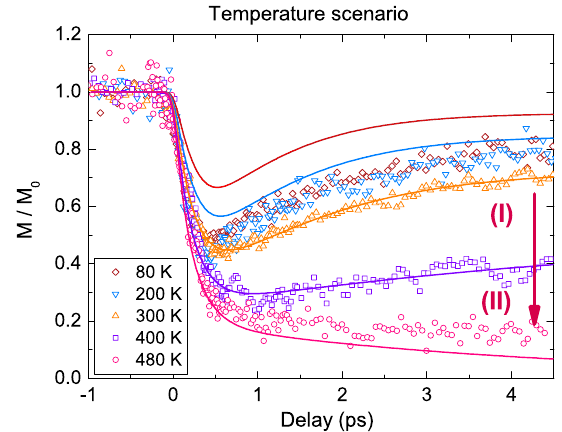
FIG. 3. Dependence of the ultrafast demagnetization of nickel on the ambient temperature T ambient at a fluence of P 0 ¼ 3 : 5 mJ = cm 2 . Demagnetization dynamics measured for five dif- ferent ambient temperatures from 80–480 K (symbols). Lines are calculations with the refined M3TM, using the microscopic parameters obtained by fitting the 300 K measurement.